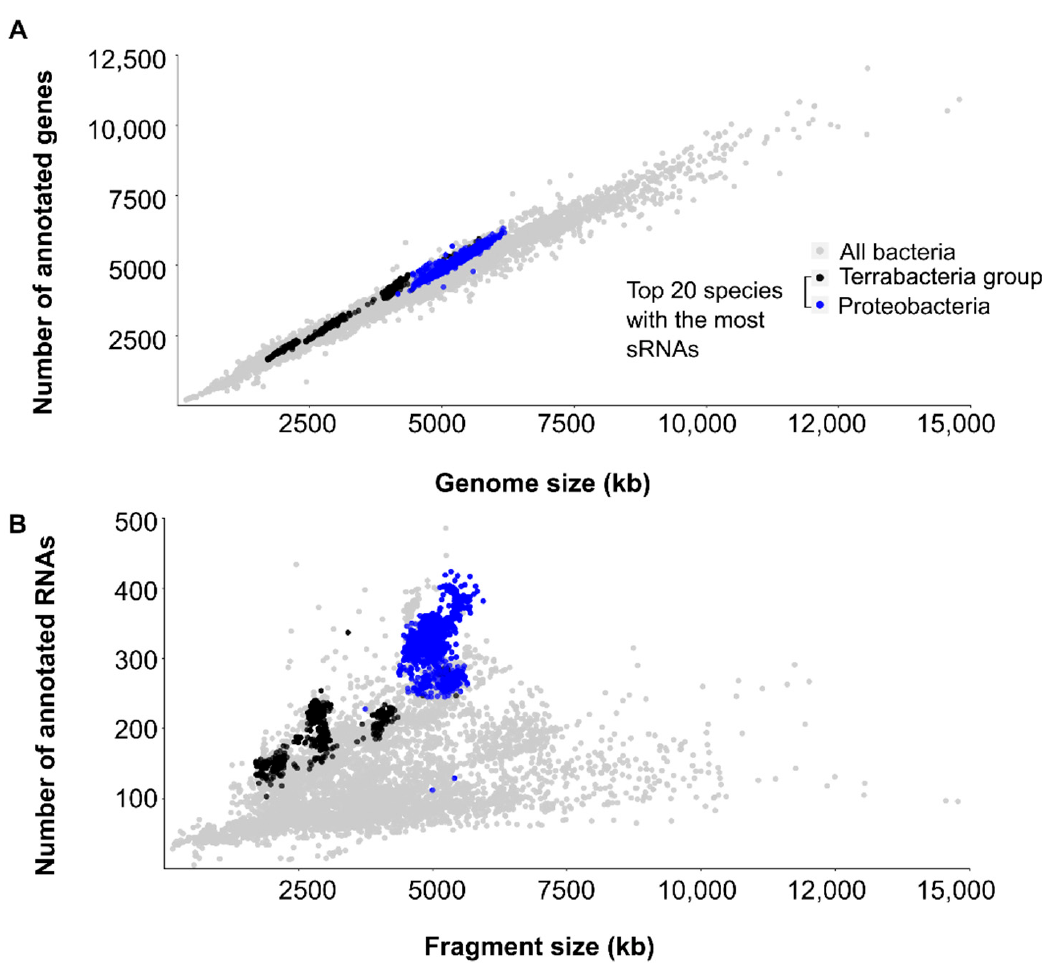
Figure 4. Number of annotated genes and RNAs in bacteria. Data required for the creation of this graph were taken from RiboGap [15]. ( A ) The number of annotated genes is graphed according to the genome size, which comprises all chromosomes and plasmids of each individual strain if applicable. ( B ) The number of annotated RNAs is graphed according to the “fragment size”, which considers chromosomes and plasmids separately for each individual strain. RNAs are not limited only to sRNAs but also include CRISPR RNAs, antisense RNAs, sRNAs, long non-coding RNAs (lncRNAs), rRNAs, ribozymes, tRNAs and cis-regulatory elements. Species from Terrabacteria group and Proteobacteria that were found to have the most annotated sRNAs (Figure 2) are represented by black and blue dots, respectively; all other strains are shown in gray. Information about genome size and the number of annotated genes and RNA comes from RiboGap [15], which extracts data from the NCBI FTP site [17]. For gene annotations, sizes are based on complete genomes, which include all plasmids and chromosomes of a given strain if applicable. However, RNAs are compiled per “DNA fragment” (chromosome or plasmid) since it is not accessible per genome within the RiboGap database. The size of each fragment was taken from all available Genbank files from the NCBI FTP site [17]. Results were limited by the available annotations. For example, some strains did not have annotated genes in NCBI and were removed from Figure 4. Moreover, some entries were mislabeled as complete genomes but were, in fact, WGS (Whole Genome Shotguns) projects with incomplete genomes, leading to a miscalculation in the number of genes (values doubled up). These erroneous data were removed from Figure 4 (shown for transparency purposes in Supplementary Material Figure